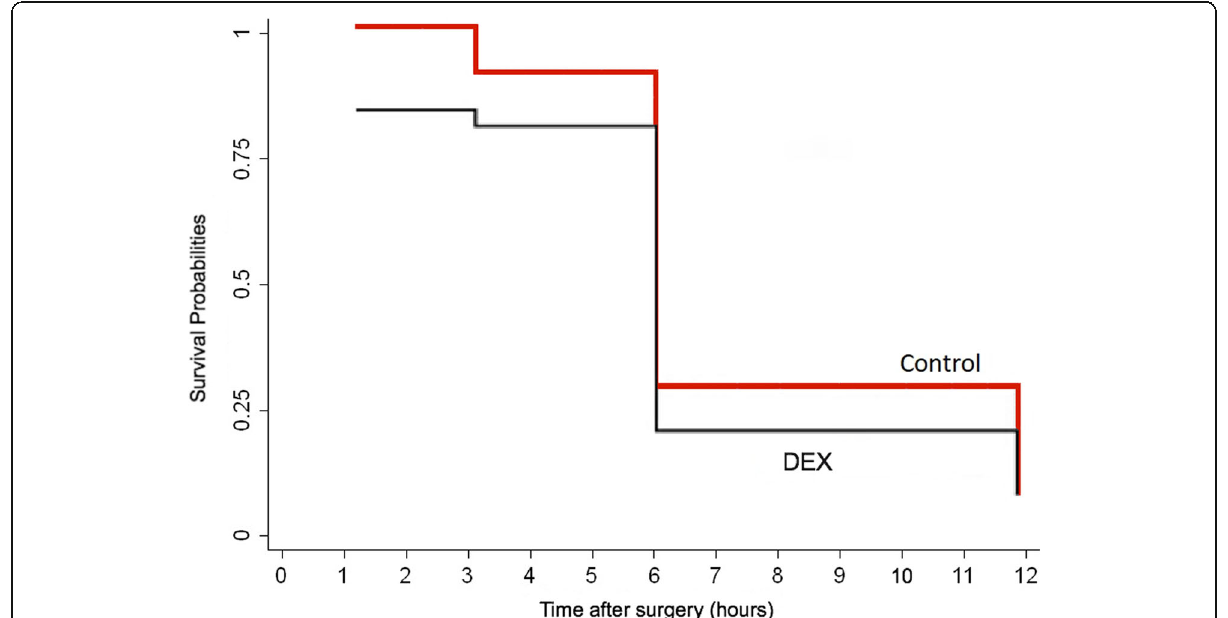
Fig. 2 Kaplan-Meier curve for estimation of the time to receive the